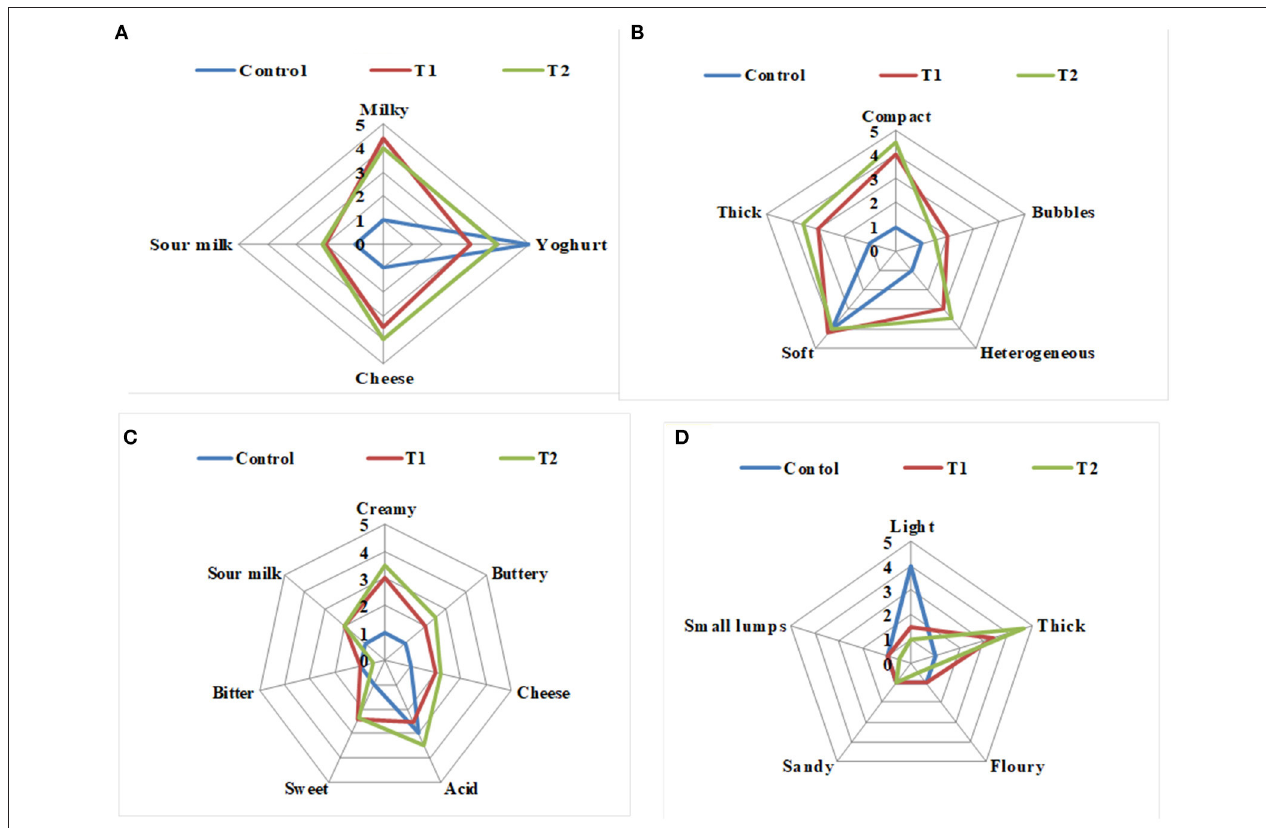
FIGURE 3 | Sensory evaluation of probiotic WPI-enriched concentrated yogurt products. (A) Odor; (B) appearance; (C) flavor; (D) mouthfeel. Data represented are means of 27 processed patches (3 times per week/9 weeks). C, control plain yogurt; T1, Pro-WPI 10% WPI-enriched concentrated yogurt; T2, Pro-WPI 20% WPI-enriched concentrated